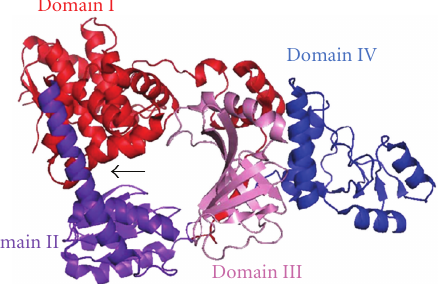
Figure 11: Crystal structure of T. thermophilus RecJ (PDB ID: 2ZXR). Full-length T. thermophilus RecJ is comprised of domains I–IV and forms a ring-like structure. The catalytic active site is located in the cavity between domains I and II as indicated by an arrow. Domain III shows a structural similarity to the oligonucleotide/oligosaccharide-binding fold that is often found in single-stranded DNA-binding proteins. The ring-like structure and oligonucleotide/oligosaccharide-binding fold will ensure the high processivity and strict specificity for single-stranded